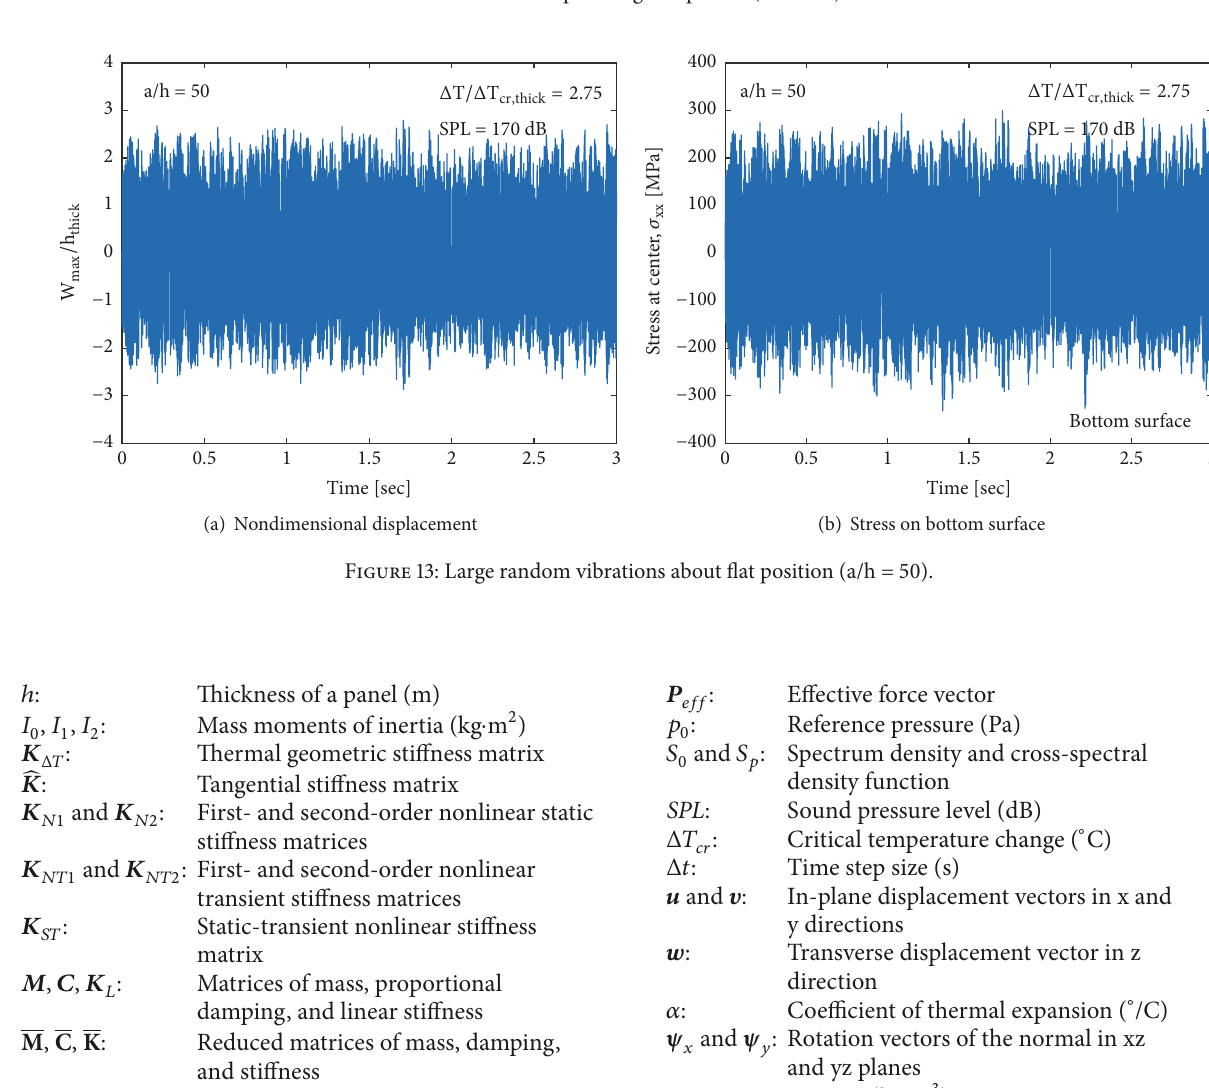
Figure 12: Snap-through responses (a/h = 50).